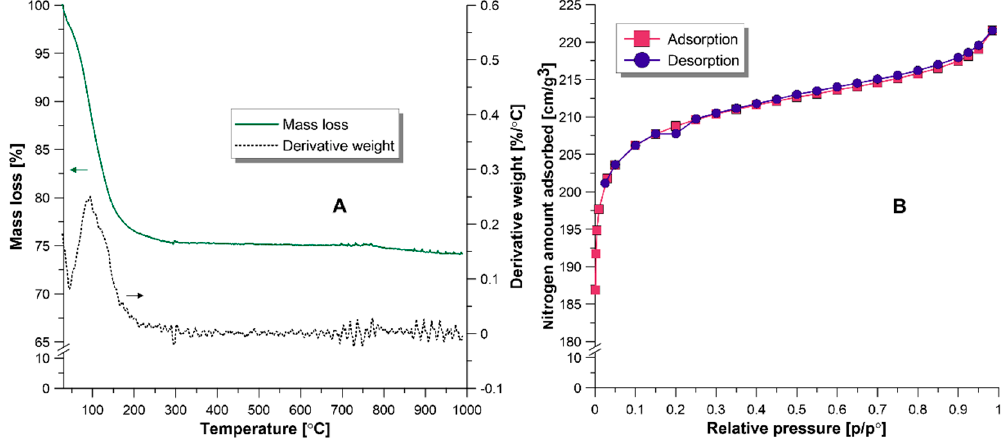
Figure 4. ( A )—TGA and DTG curves of NaY zeolite. ( B )—N 2 adsorption isotherm of NaY.